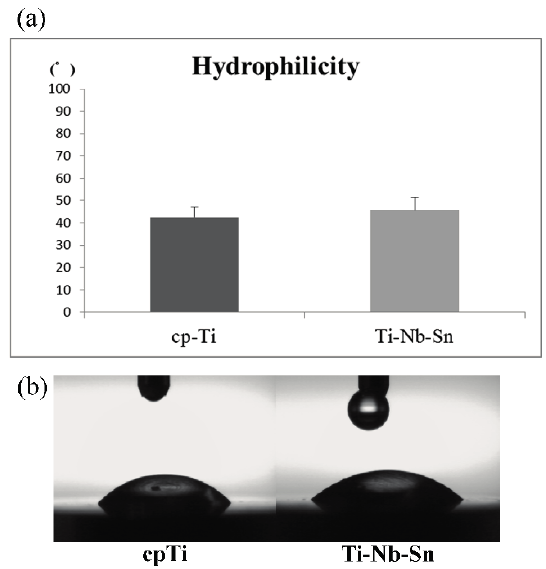
Figure 2. Hydrophilicity of cpTi and Ti-Nb-Sn alloy disks. ( a ) Mean contact angle of 1 μ L H 2 O onto the cpTi and Ti-Nb-Sn alloy disks. Data are the mean ± SD ( n = 8); ( b ) Photographic images of H 2 O droplets pipetted onto the cpTi and Ti-Nb-Sn alloy disks.